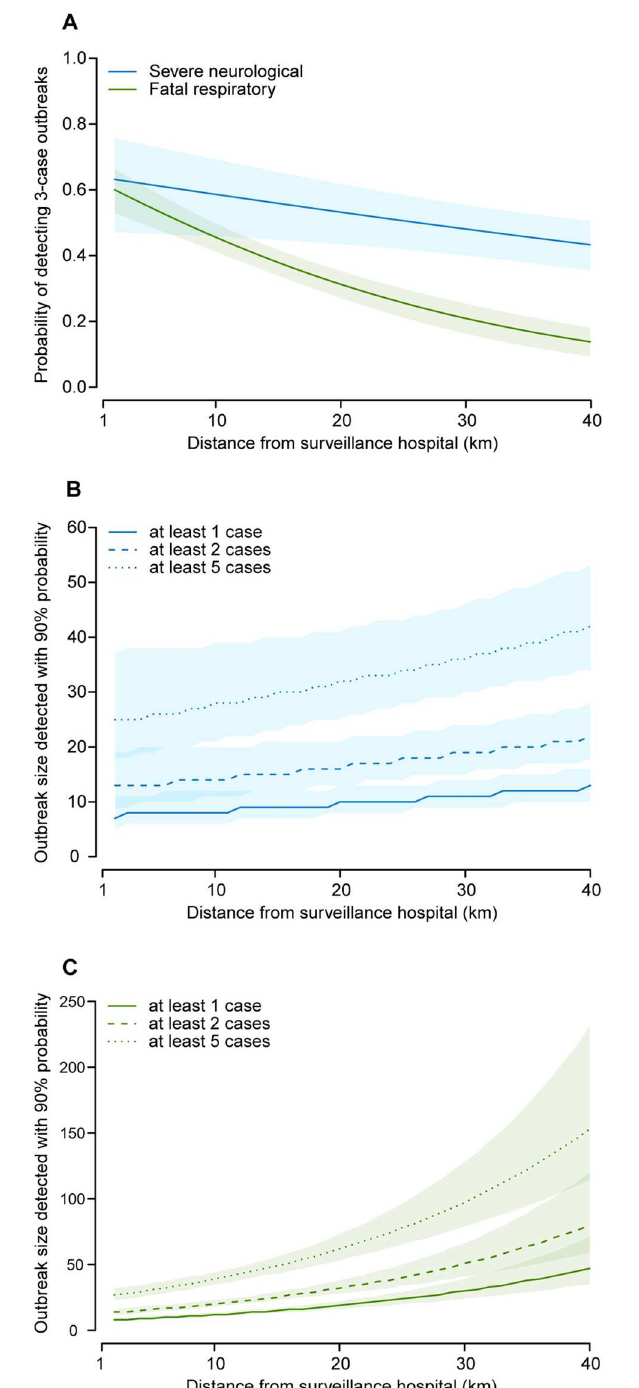
Fig 3. Outbreak detection capacity. (A) Probabilityof detectingoutbreakswith exactly three cases of severe neurologicalor fatal respiratorydisease by distancefrom surveillance hospitalif a single detected case is considered an outbreak. (B) Smallest size of severe neurologicaldiseaseoutbreak that would be detected with (cid:21) 90% probabilityby distancefrom surveillance hospital for outbreakthresholdsof at least one, two, or five detected cases. (C) Smallest size of fatal respiratory diseaseoutbreakthat wouldbe detected with (cid:21) 90% probabilityby distancefrom surveillance hospitalfor outbreak thresholds of at least one, two, or five detected